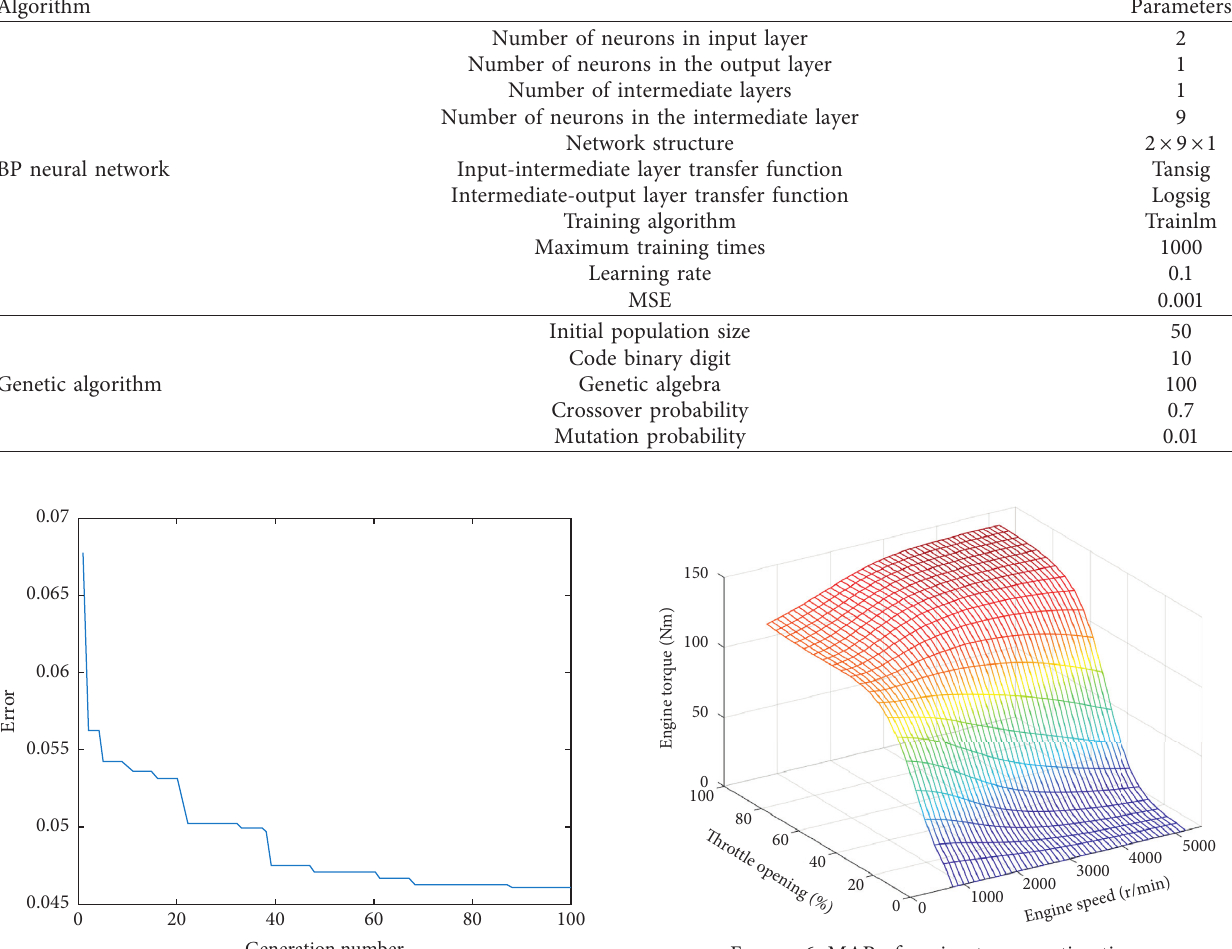
Figure 4: Genetic algorithm error.